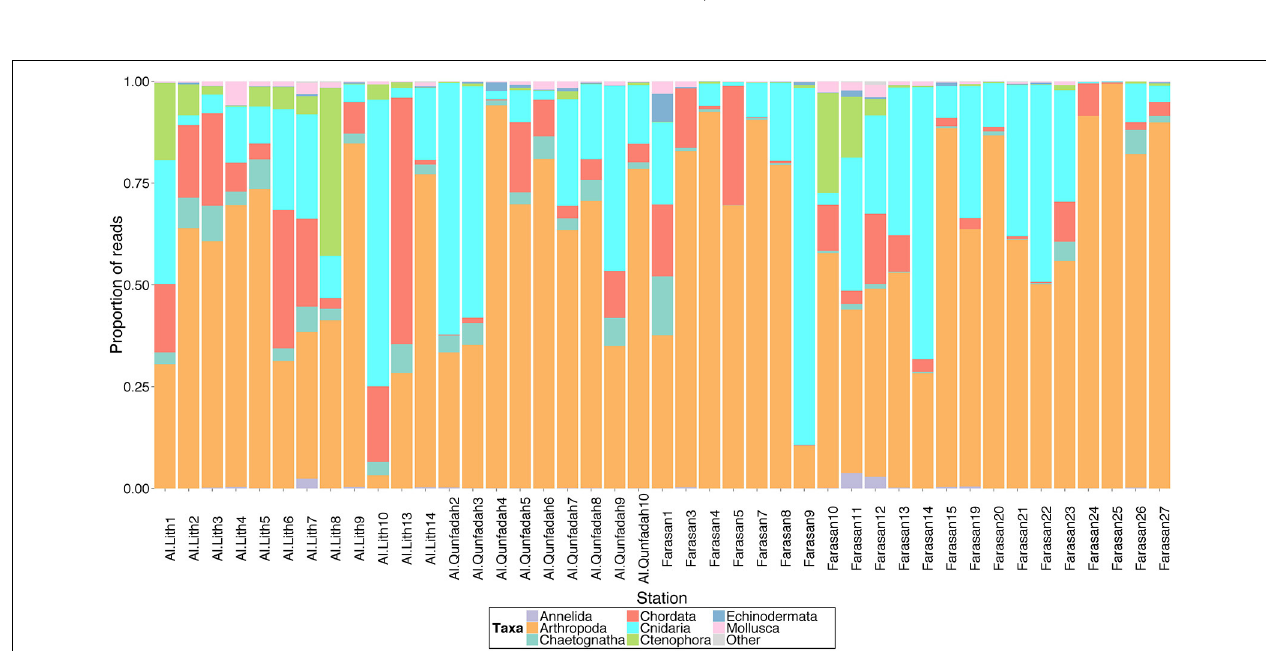
FIGURE 5 | Proportion of reads assigned to metazoan taxa across all stations for the 1389F primer dataset in the central/southern Red Sea.